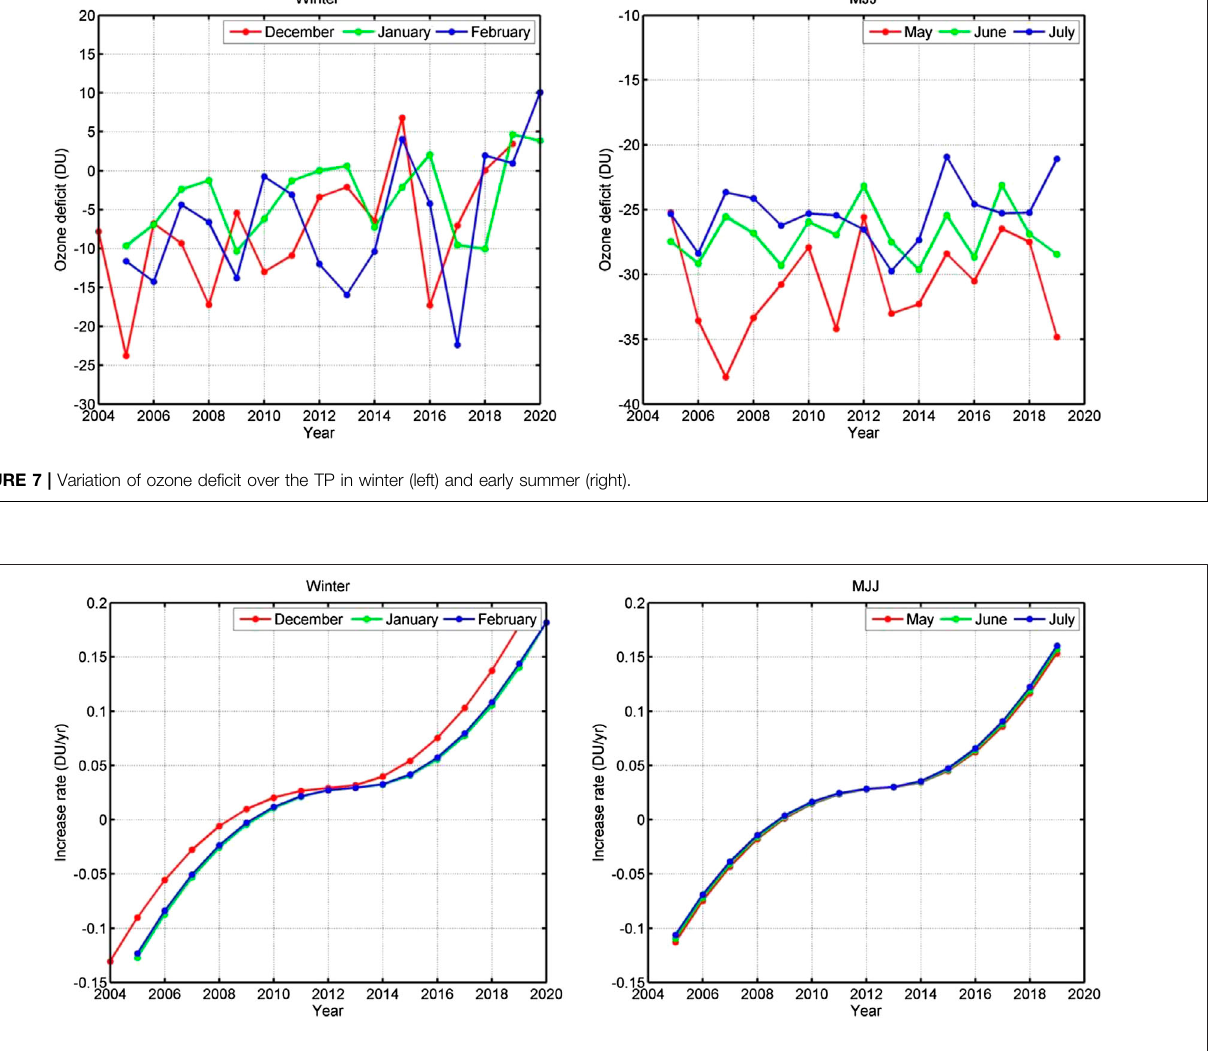
Frontiers in Earth Science |